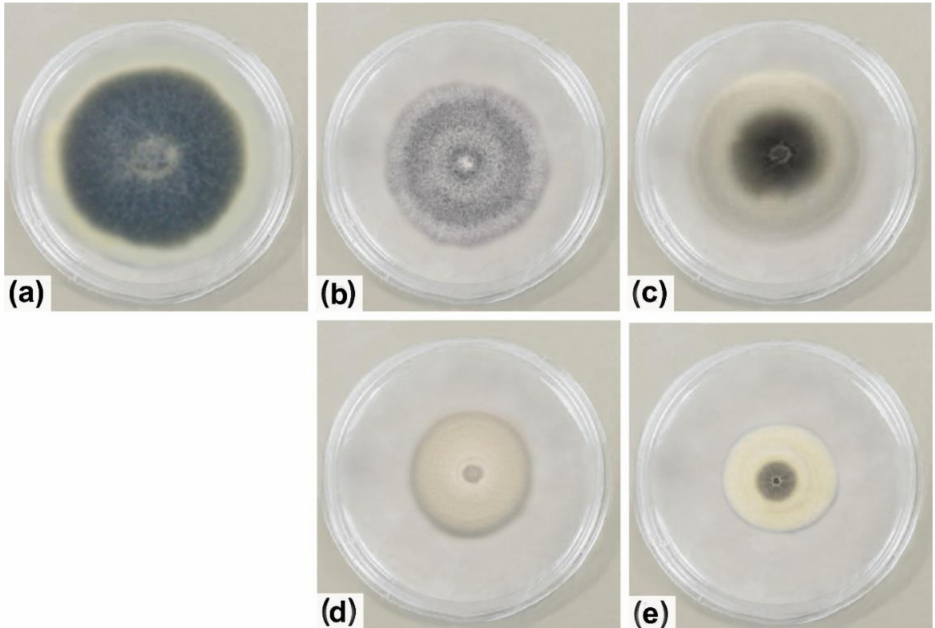
Figure 11. Influence of silatrane polymers on the growth of Verticillium dahliae colonies. ( a ) control colony; ( b ) polymer 3c; ( c ) polymer 4c; ( d ) polymer 3d; ( e ) polymer 4d. The time after inoculation is 7 days.